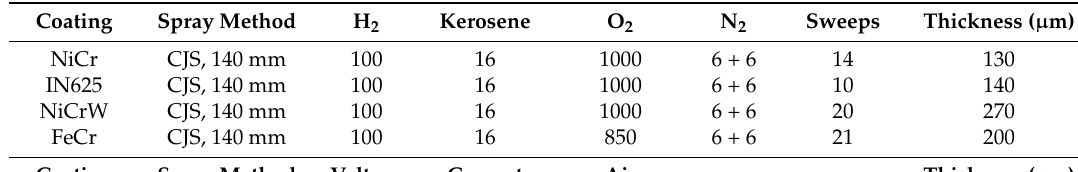
Table 2. Process parameters for high velocity oxy-fuel (HVOF) spraying (L/min). Below: process parameters for arc spraying.